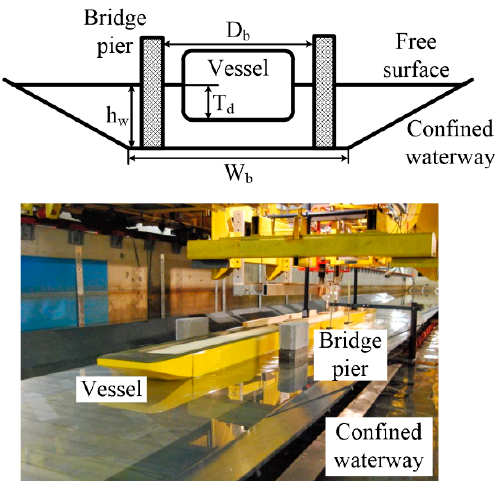
Figure 2. Schematic and photo of the inland convoy passing the bridge piers.